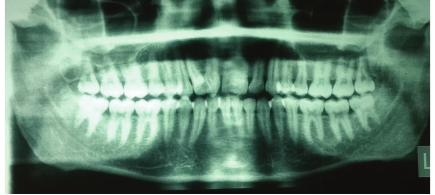
Figure 2: Orthopantomograph showing geminated maxillary cen- tral incisors with split roots.